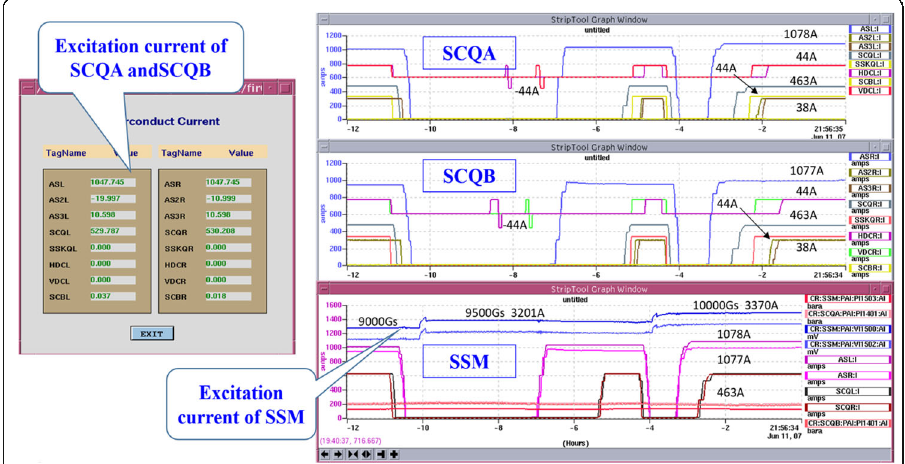
Fig. 15 Historical parametric curve during operation of SSM and SCQ cryogenic